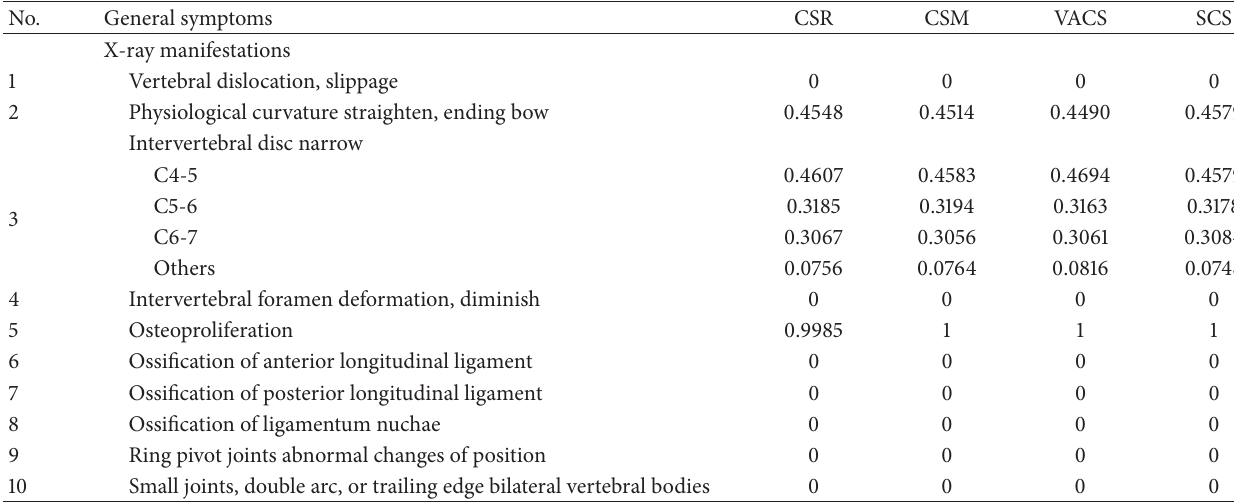
Table 2: CS Symptoms versus Types.